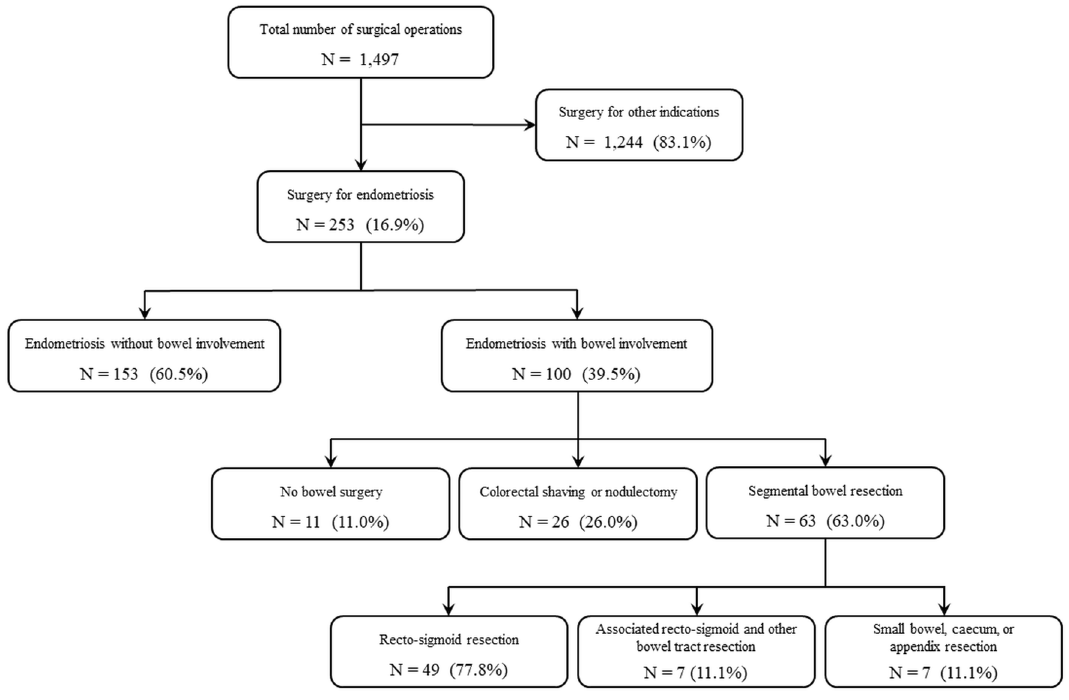
Figure 2. Case selection